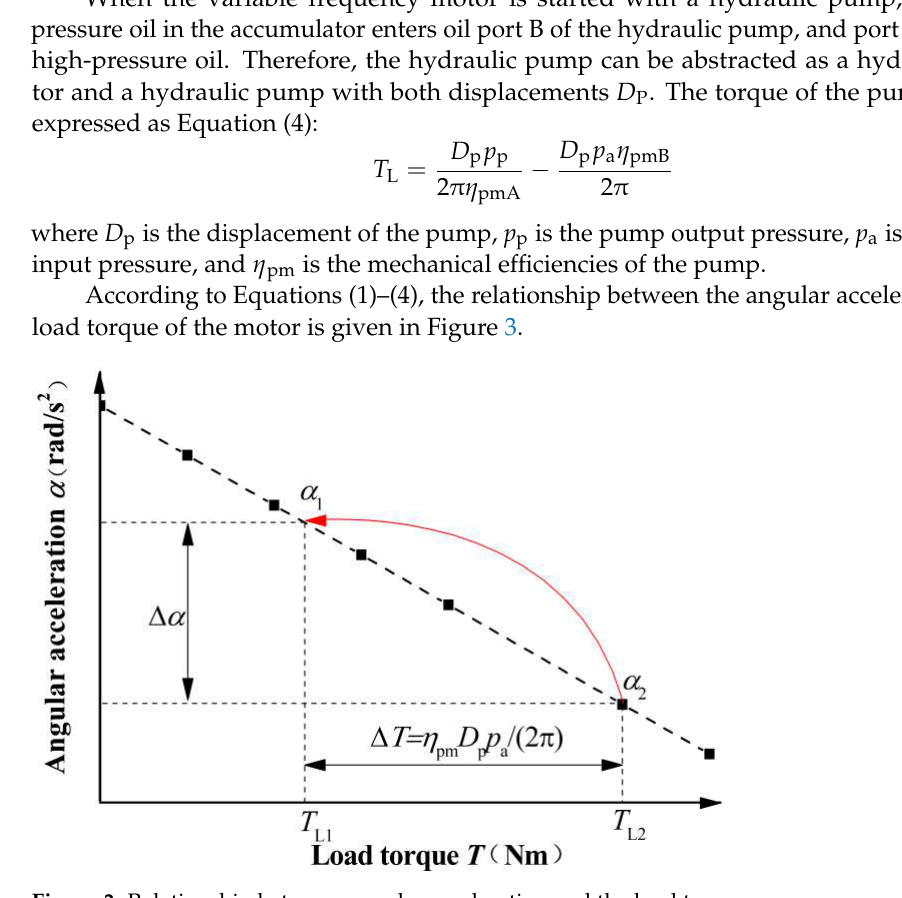
Figure 3. Relationship between angular acceleration and the load torque. According to Equation (4) and Figure 3, if the pressure oil in the accumulator is introduced to the pump inlet port, the hydraulic pump works under “motor” mode, and it can drive the electric motor’s acceleration; thus, the dynamic response performance of the power source can be improved and the starting current can be decreased. As mentioned above, the assisting torque generated from the pump is directly pro- portional to the pressure and the displacement of the pump. Additionally, considering the system rotational inertia, the electric motor’s rated torque and the required response time, a minimum working pressure of the accumulator can be determined. gas thermodynamic equilibrium equation, the process can be expressed as Equation